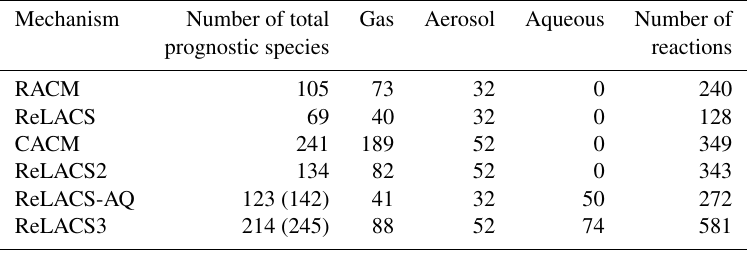
Table 3. Chemical mechanisms available in Meso-NH with the number of total prognostic species, the decomposition among gas, aerosols, and aqueous species, and the number of reactions. For ReLACS-AQ and ReLACS3, the numbers in parentheses include the precipitating ice mixing ratios for mixed-phase clouds.